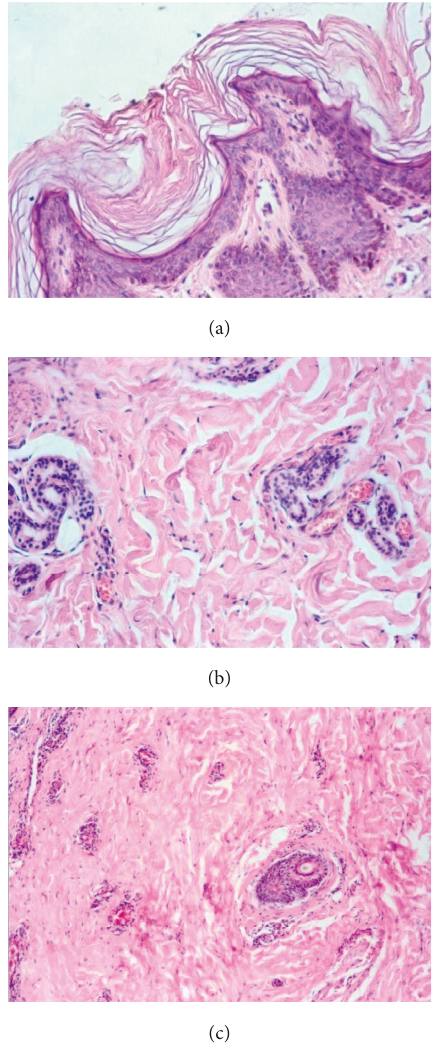
Figure 3: Patient 1. Histological sections showing hyperkeratosis (a), atresia of sweat glands and absence of sebaceous glands (b), and atrophic hair follicles (c) (original magnification: × 200 and × 100; hematoxylin and